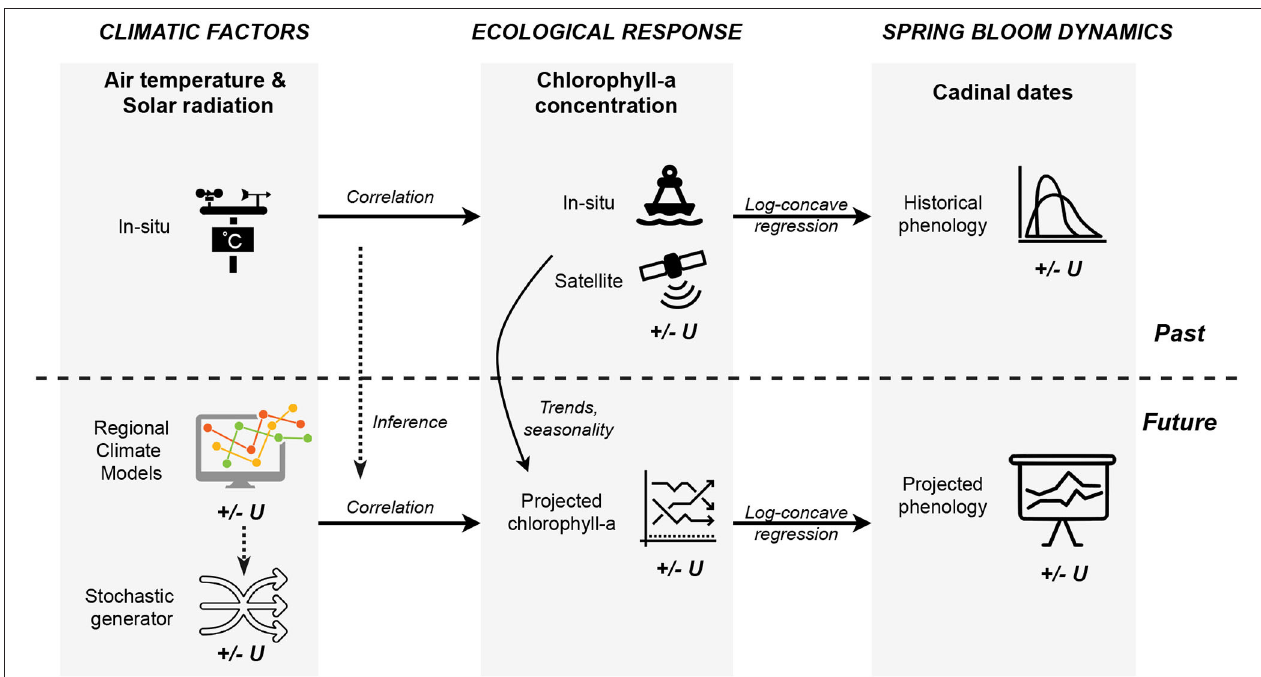
FIGURE 1 | Methodological framework including three main elements with causal and temporal relations: (1) climatic factors, (2) ecological response, and (3) spring bloom dynamics.